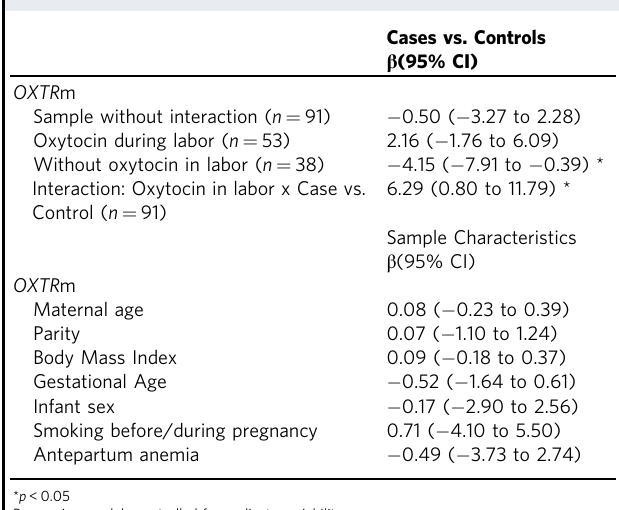
* p <0.05 Regression models controlled for replicate variability. OXTR m was not related to other sample characteristics.